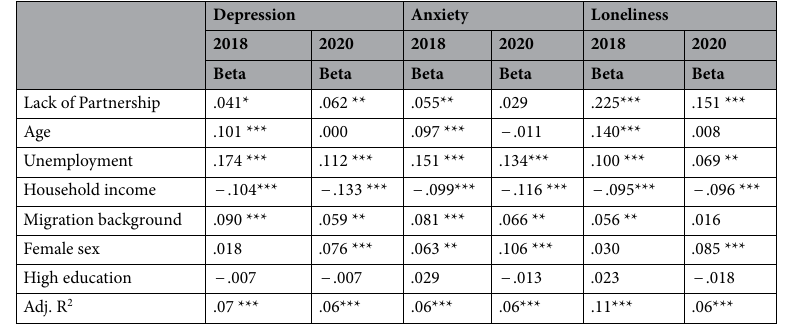
Table 2. Determinants of depression and anxiety symptoms, and loneliness in 2018 and 2020. * p < 0.05, ** p < 0.01, *** p <